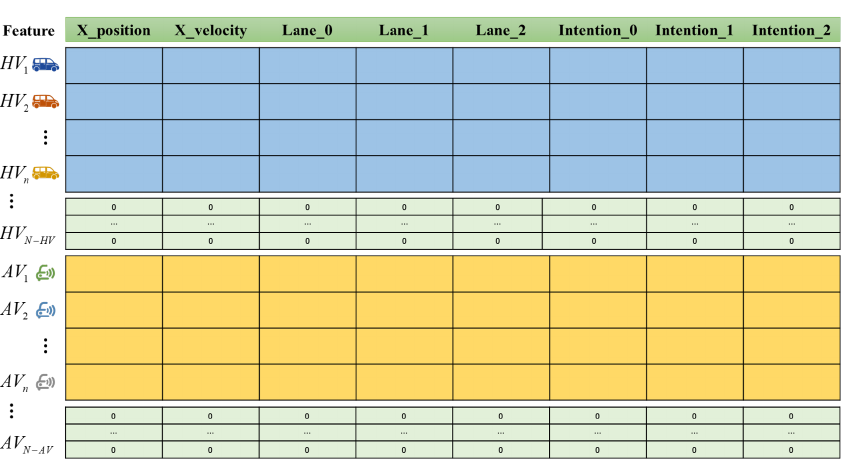
Figure 3. Matrix segmentation diagram. Each row in the matrix represents the characteristic informa- tion of a vehicle, and the matrix is divided into the upper and lower parts to separate AV and HV. The green part indicates that the vehicle is not currently in the scenario.